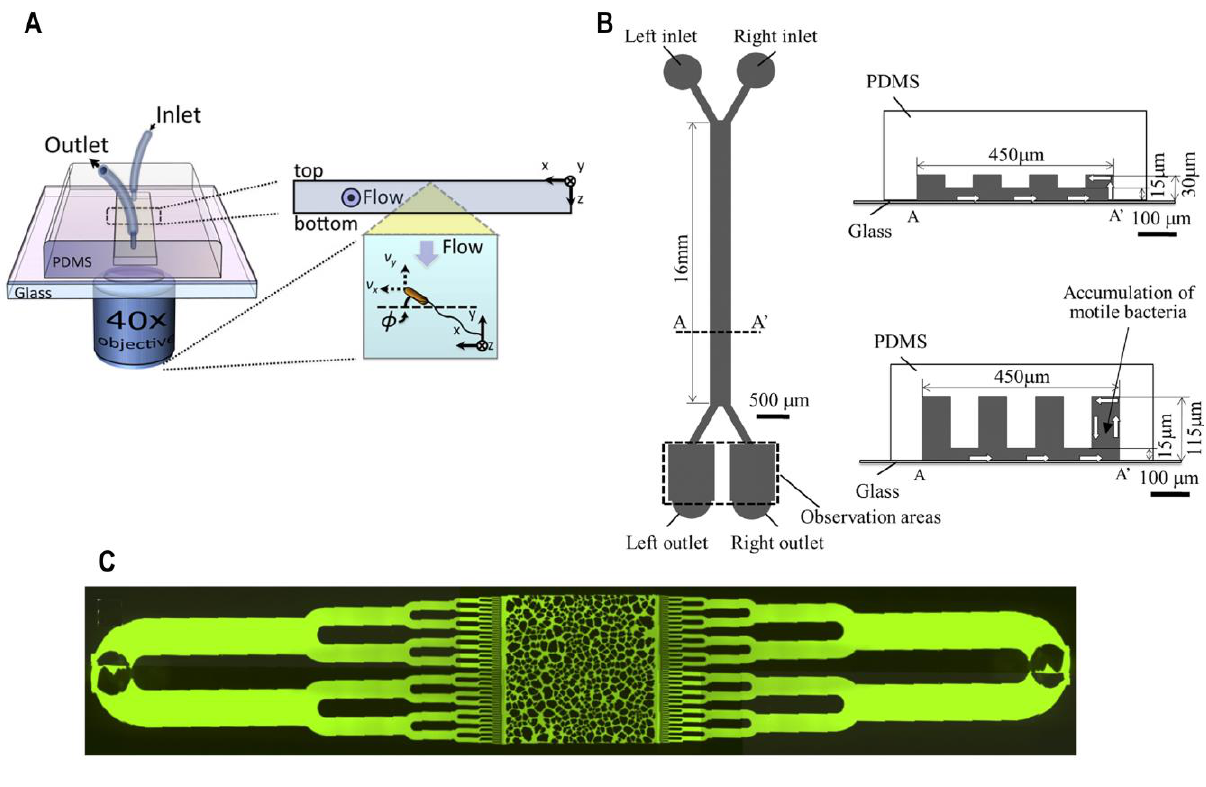
FIGURE 4: Microfluidic device for bacterial rheotaxis. (A) A rectangular channel with a single inlet and outlet was fabricated over an inverted microscope objective lens. Motile bacteria flowed into the channel were tracked using a microscope. Reproduced from [40]. (B) Partition-wall protrusions of height ranging from 30 - 115 µm were fabricated from PDMS to create the left and right channels. Under controlled flow, mo- tile bacteria flowed into via the left inlet swam towards the right channel and could be collected at the right outlets. Reproduced from [42]. (C) A microfluidic chip was fabricated with microchannels that resembled the texture of porous media. Bacteria were located at the inlets at the extremities of the chip which gradually get distributed into the chip under gravity-driven flow. Reproduced from